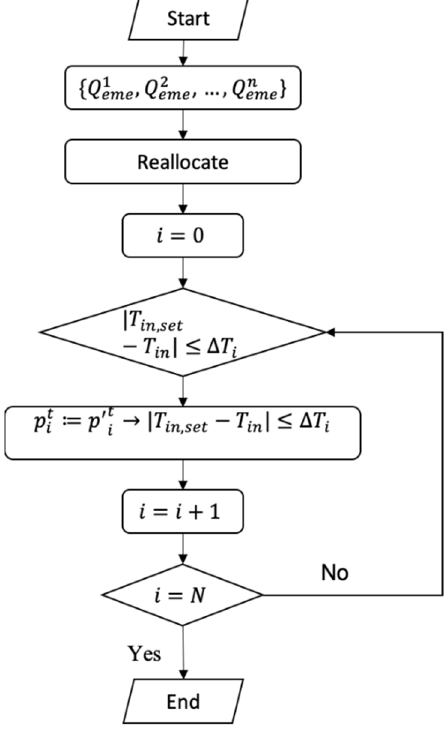
Figure 4. Flow chart of the day-ahead energy optimisation and scheduling.